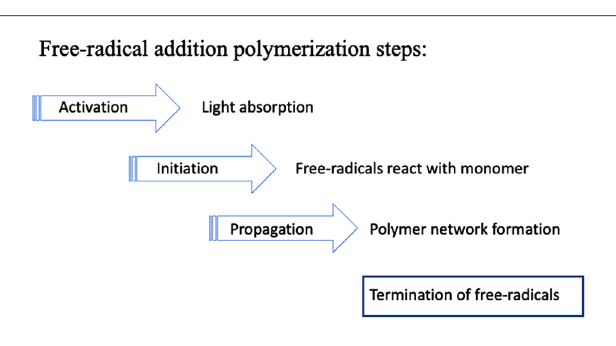
FIGURE 8 Free-radical polymerization involves successive steps. Initiation creates monomer molecules with unpaired electrons. During propagation these radicals combine with further monomers forming growing polymer chains. Eventually the growth process stops due to one or more termination